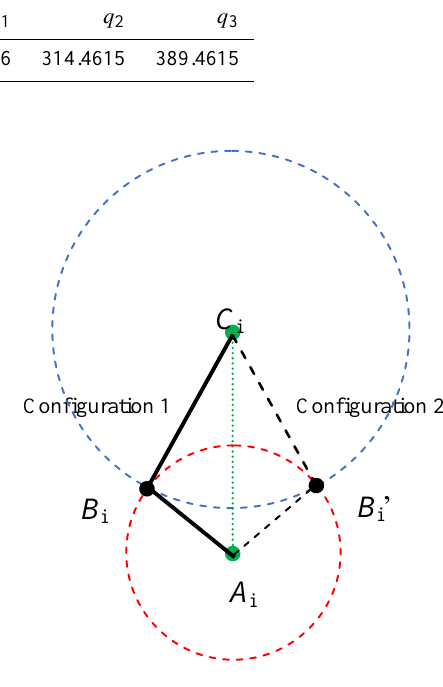
Figure 9. Two possible configurations of a CRU